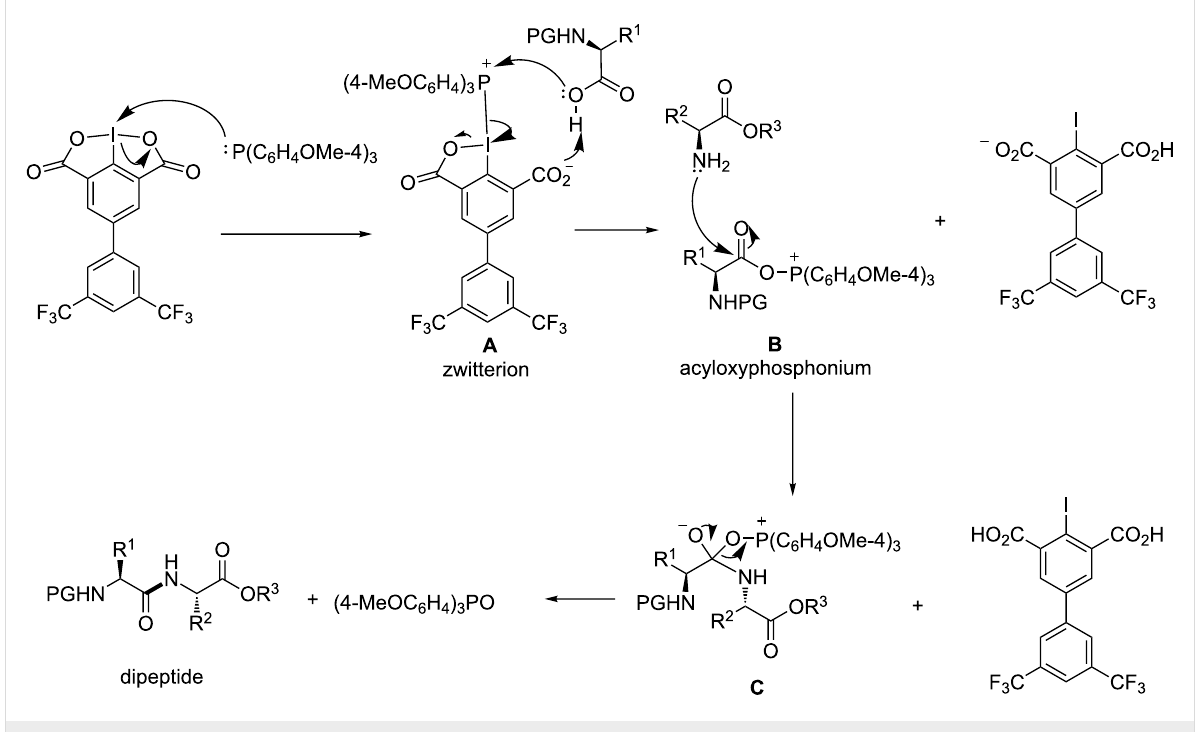
Scheme 1: Proposed mechanism for FPID-mediated amide bond formation.